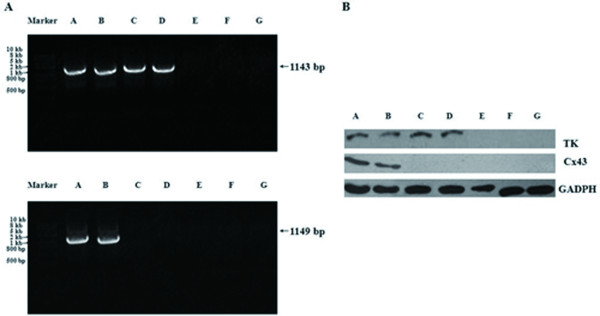
Expressions of TK and Cx43 after PC-3 cells transfection. A. The TK bands of 1143 bp were detected in Group A, B, C, D and the Cx43 bands of 1149 bp were only detected in Group A and B. B. The TK proteins were detected in Group A, B, C, D and the Cx43 proteins were only detected in Group A and B. Equal loading was confirmed by stripping the blot and reprobing it for GAPDH.